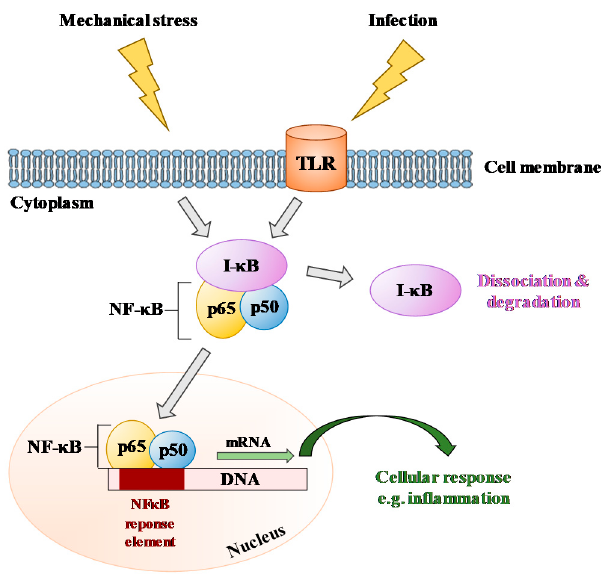
Figure 9. Schematic presentation of a major signaling pathway frequently affected in many differ- ent cell types of different species in response to altered gravity, mechanical stress, or infection. NF- κ B: nuclear factor-kappa B; I- κ B: inhibitor of κ B; TLR: Toll-like